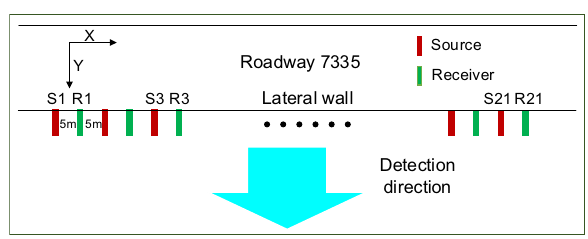
Fig. 14 Field collection layout diagram